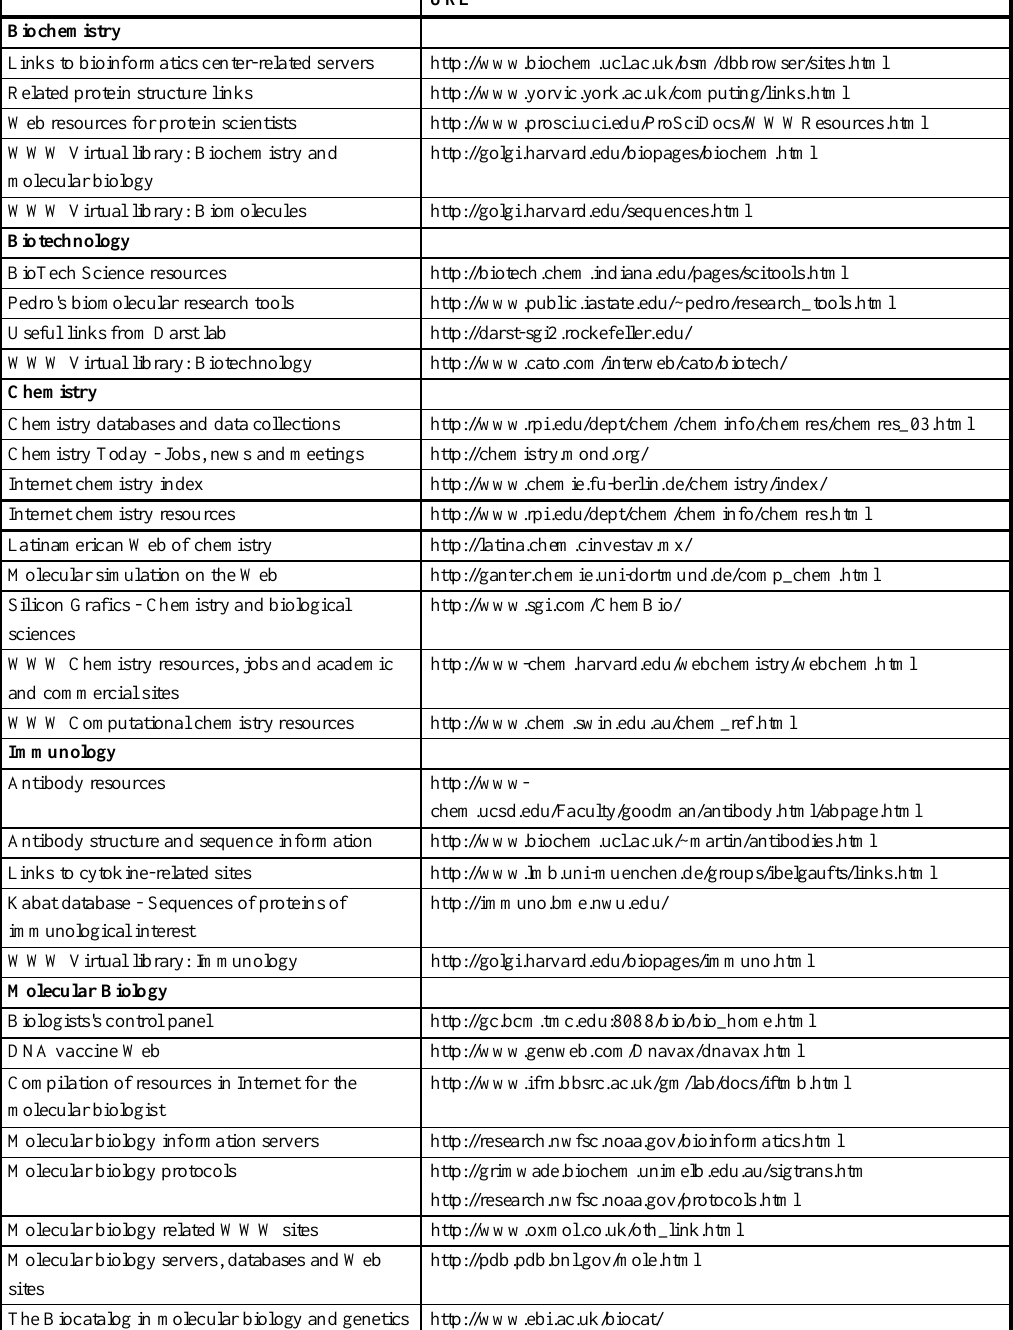
Table 1 - Protein-related